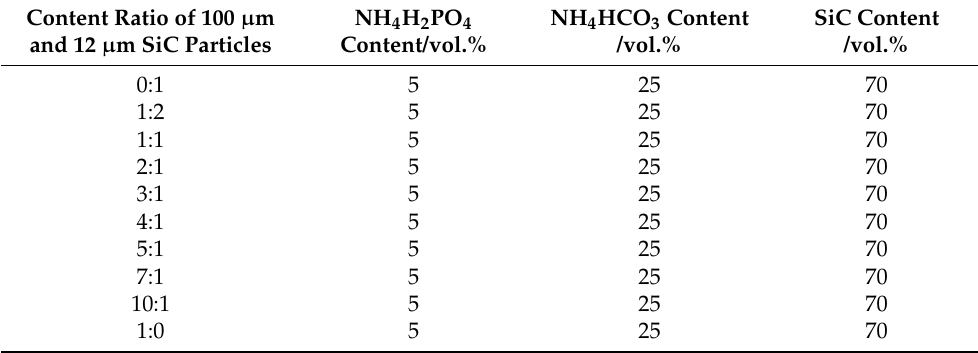
Table 1. Experimental scheme of 2 kinds of SiC particles with different proportions. Content Ratio of 100 µ m and 12 µ m SiC Particles